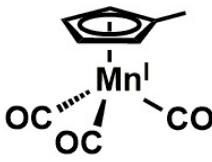
Figure 6. Manganese structure.